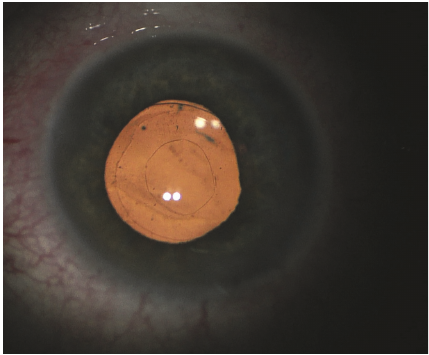
Figure 1: Well-de fi ned patent posterior capsulotomy (vitrectorhexis) with a well-centralized